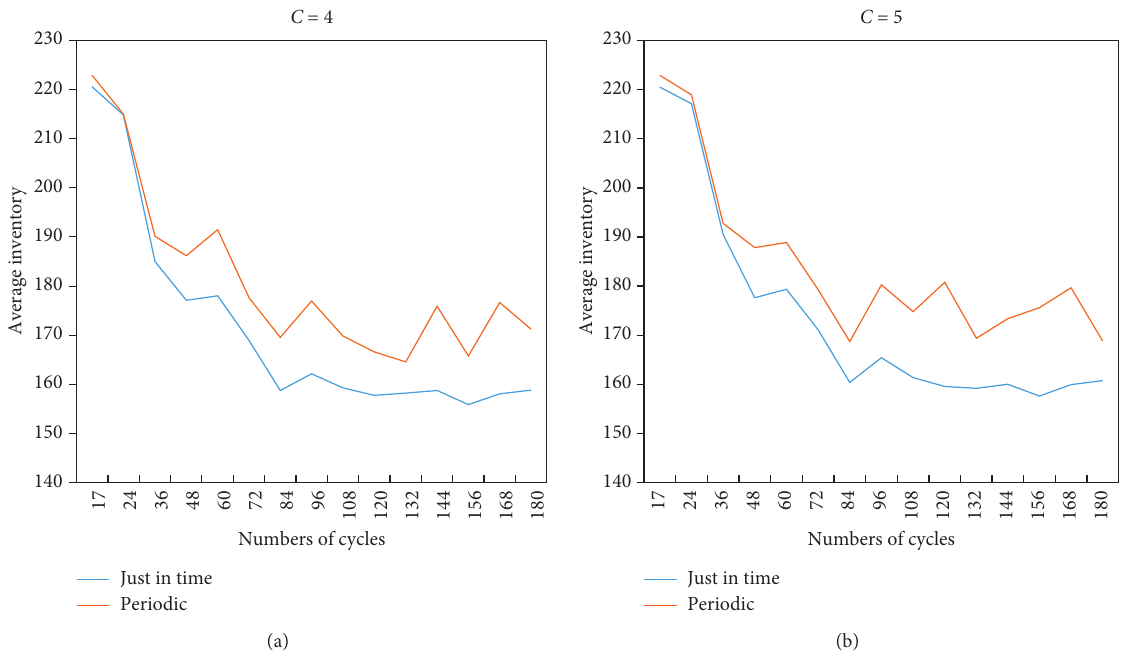
Figure 3: Average inventory of delivery strategies under different capacities of tow